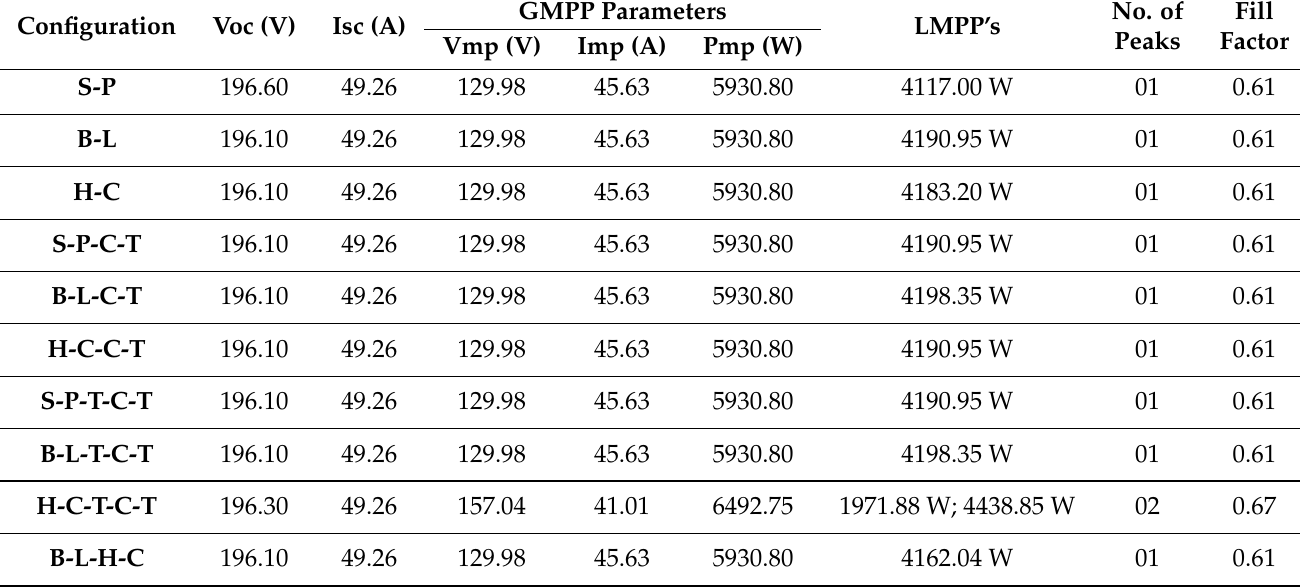
Table 2. Parameter variations of conventional and hybrid configurations under uneven-row pattern.